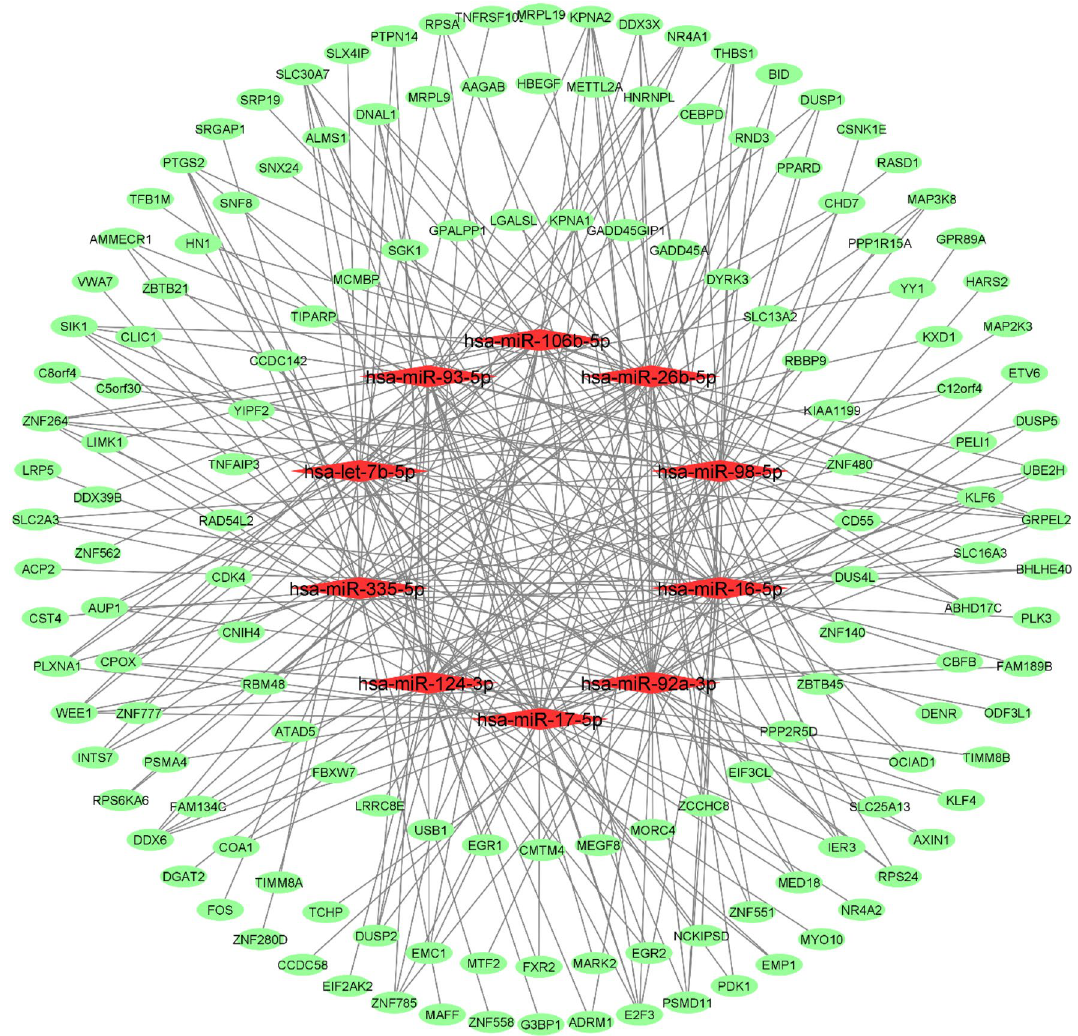
Figure 3. Bipartite mRNA-miRNA subnetwork for NBMSC-RNIT. Cytoscape v.3.8.2 was used to visualize the network.